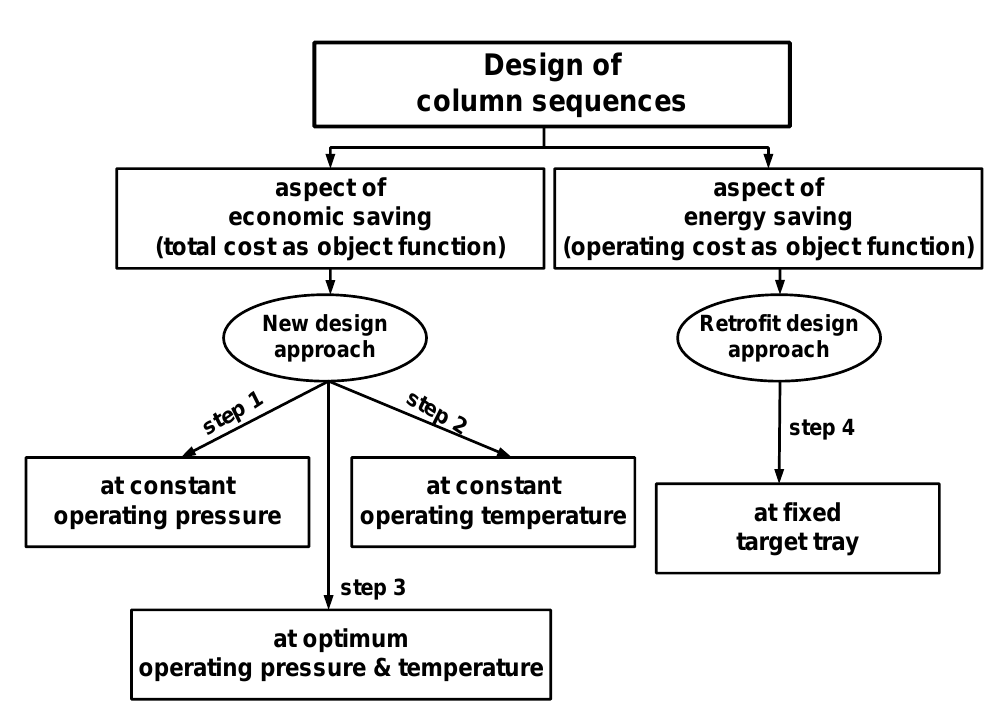
Figure 3. Global steps of